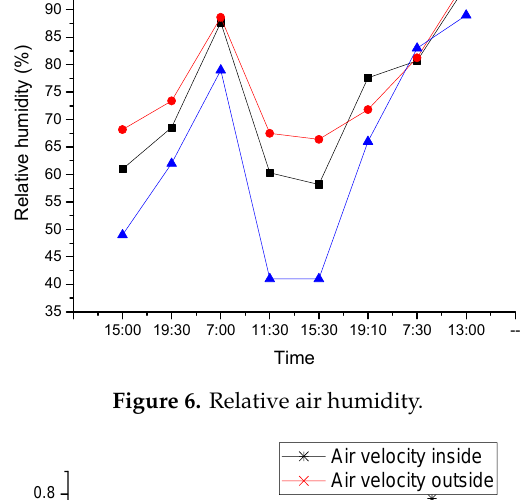
Energies 2020 , 13 , x FOR PEER REVIEW